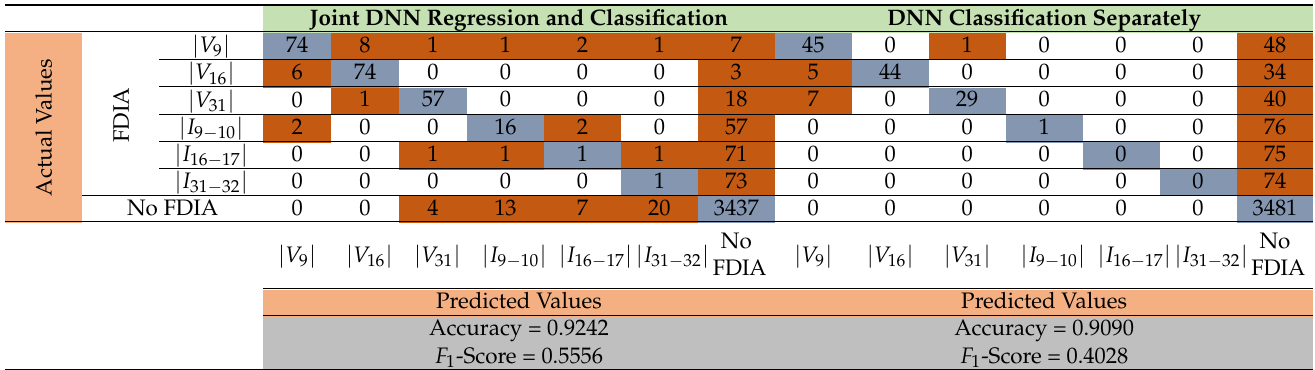
Figure 8 shows the results of DSSE calculation from the proposed method, the regression-only method, and the WLS method. It is clear from the figure that the pro- posed method has a better performance in the MPE and MAE criteria compared to other methods in the presence of bad data. Similar to what was seen in the previous case study, when no bad data are present, both DNN-based methods (regression-only and combined regression and classification) have similar performance for state estimation. The WLS estimator has the worst performance in both cases, and the performance is significantly worse in the presence of bad data measurements.